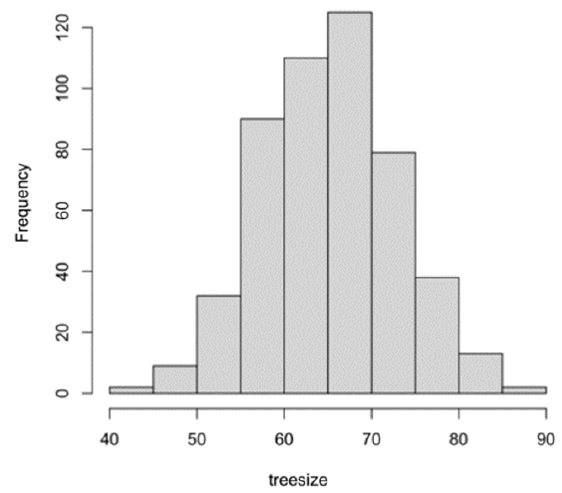
Figure 2. T he figure of variable importance ranking in the macrosomia random forest prediction model.